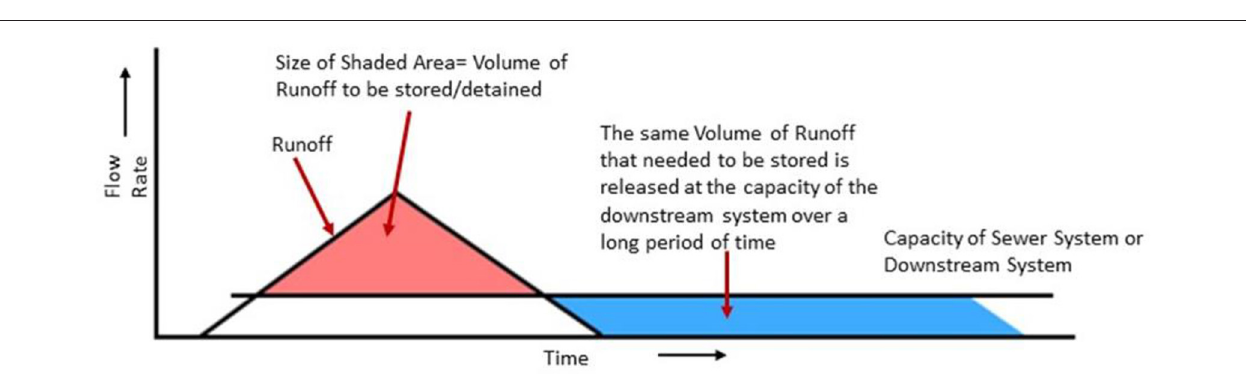
FIGURE 2 | Conceptual Representation of Operation of Dual Drainage